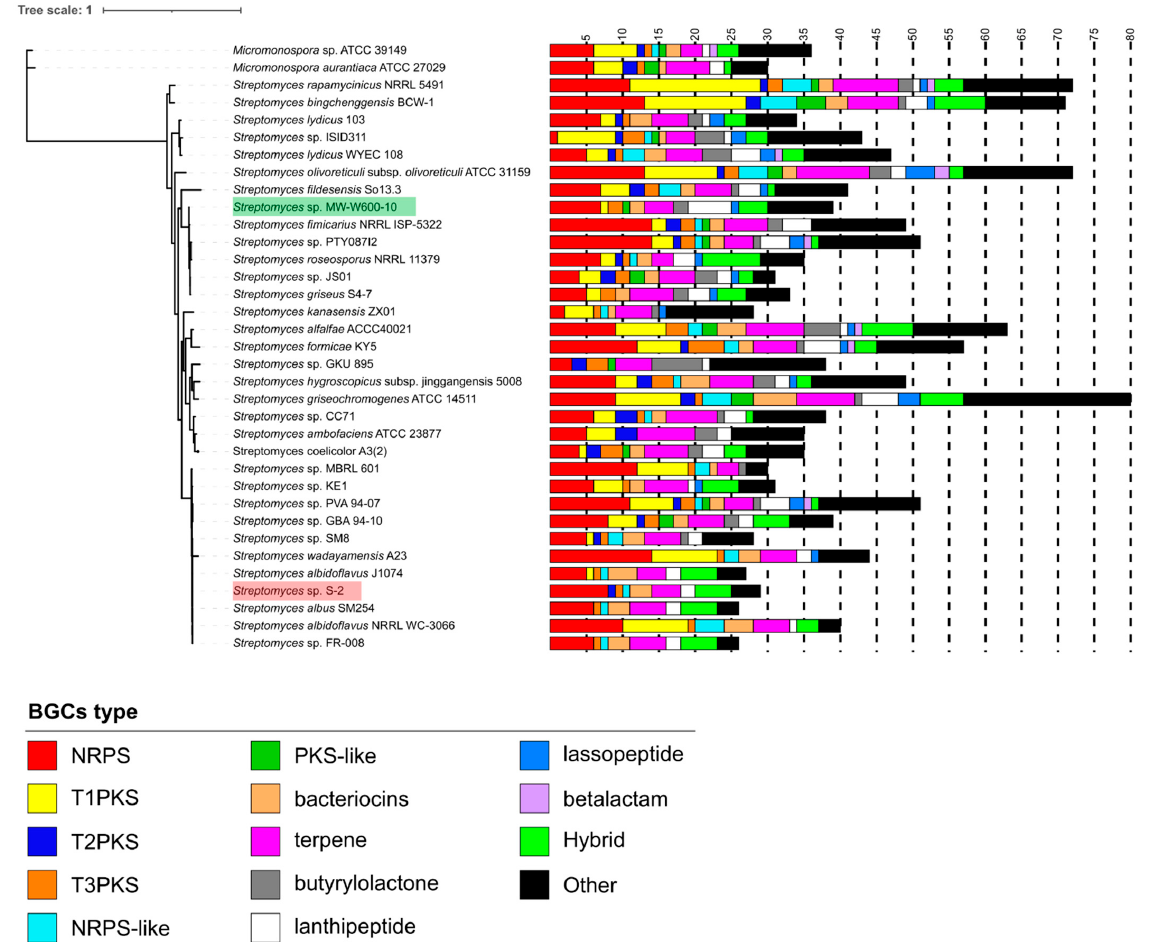
Figure 6. Comparison of number of BGCs in genomes of closely related Streptomyces strains and strains reported to have a high number of clusters. The BGCs were predicted using the antiSMASH tool, the results were manually investigated, “neighboring” clusters were not counted, and “interleaved” clusters were counted as separate clusters. Clusters not belonging to the shown groups were pooled in the “other” group. The maximum likelihood tree was generated based on the alignment of 18 single-copy genes found in each strain, where positions of coal-related strains have been highlighted for better visibility—MW-W600-10 in green and S-2 in